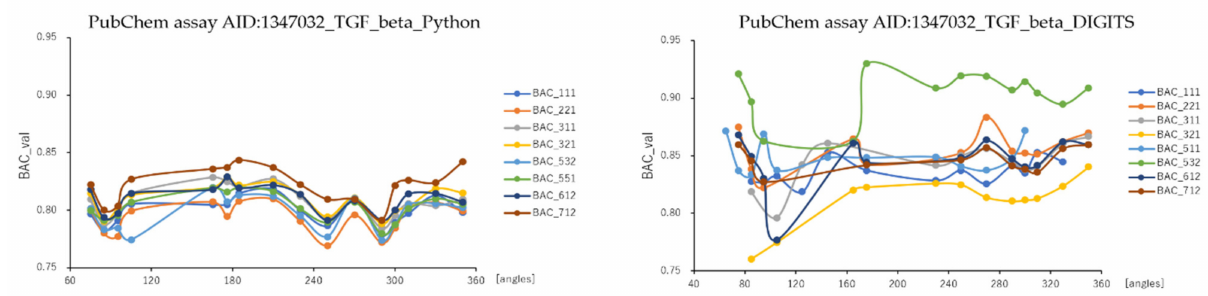
Figure 3. BAC with angles in DeepSnap-DL using TensorFlow and DIGITS of prediction models of the glucocorticoid receptor (PubChem assay AID:720725_GR_ant), TGF-beta/Smad (PubChem assay AID:1347032_TGF_beta_ant), and agonist of the thyrotropin-releasing hormone receptor (PubChem assay AID:1347030_TRHR_ago) in the validation dataset; n = 3.